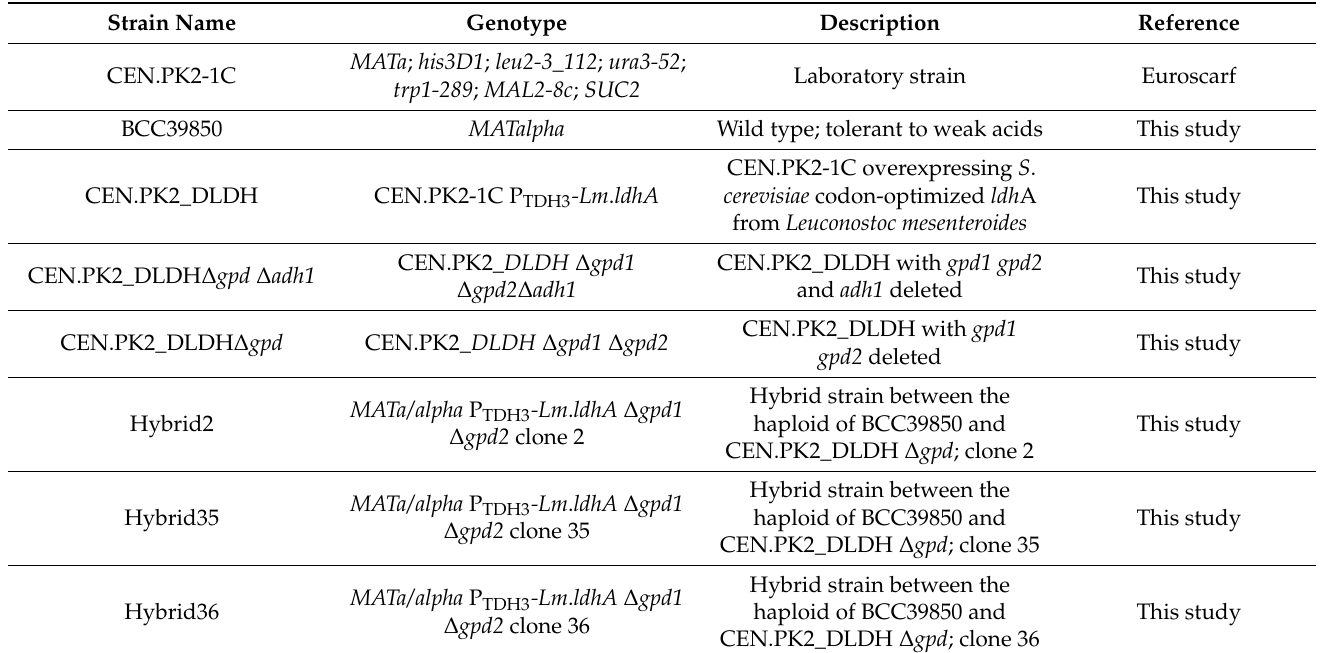
Table 1. Strains used in this